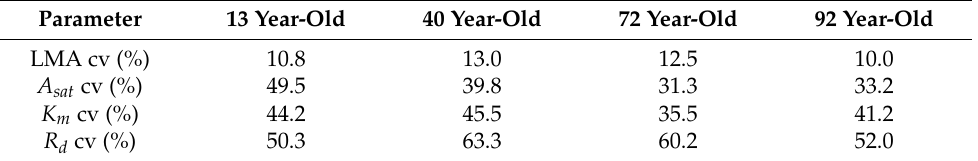
Table A3. Seasonal coefficient of variation (cv) for Leaf Mass per Area (LMA, g m − 2 ), saturated net and dark respiration rate ( R d , µ mole m − 2 s − 1 ).